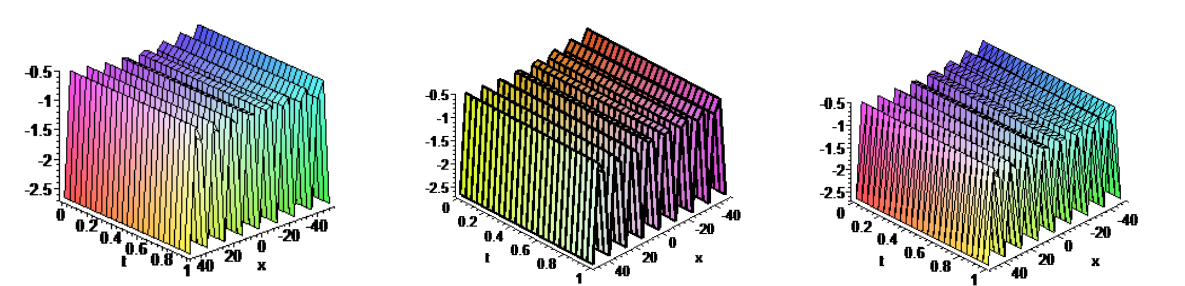
Fig. 2 3D curves of Hybrid method, Exact and RDTM solutions for t = 0 , 0001,